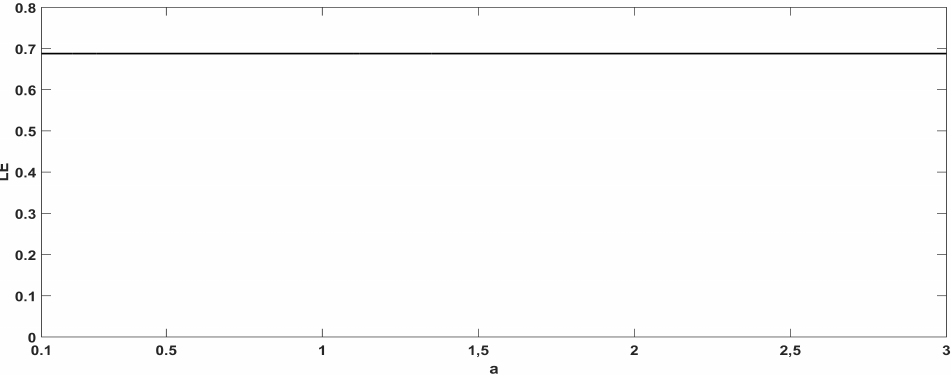
Figure 6. LE diagram with respect to parameter a , for b = 1.99, r =